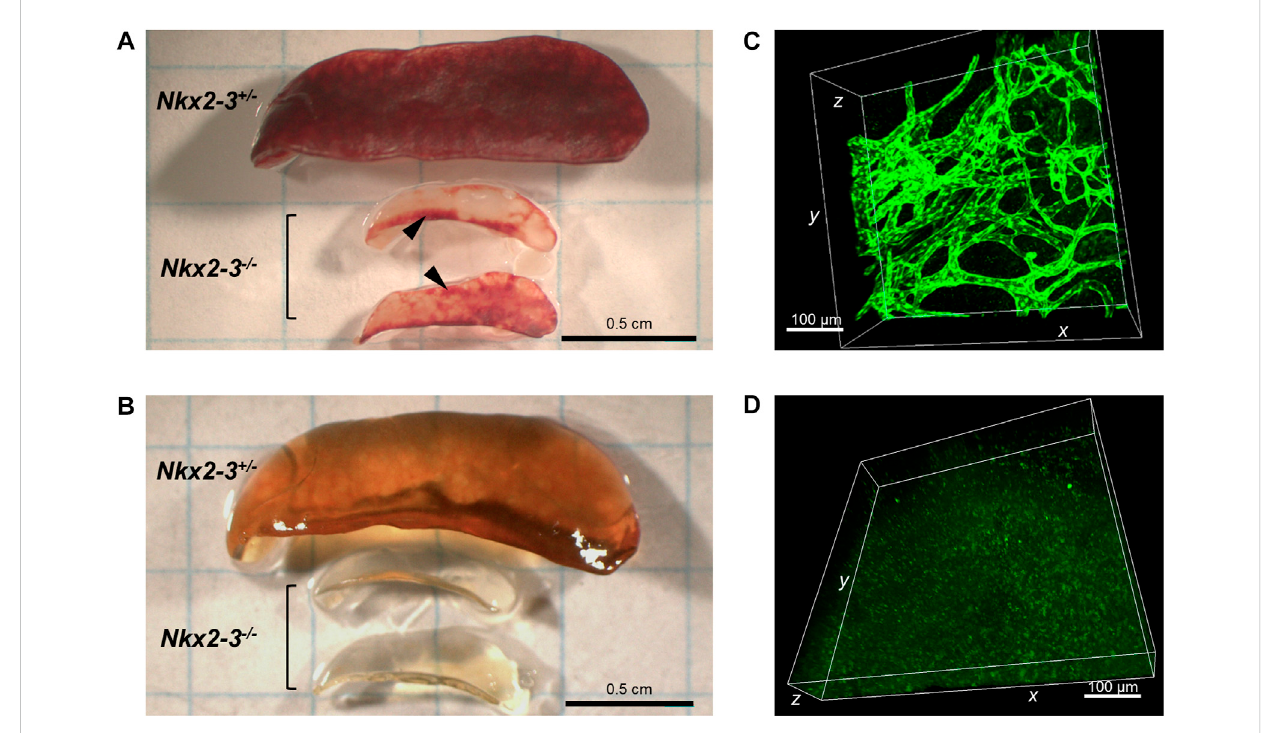
FIGURE 1 Organziation ofProx1-expressing lymphaticcapillariesinNkx2-3 − / − spleens.Compared toheterozygotesample(top)Nkx2-3-de fi cient micehavea reduced spleen size and patchy red pulp appearance (middle and bottom) (A) . Following paraformaldehyde fi xation and transparency treatment of the same samples, the heterozygote tissue (top) could not be clari fi ed due to residual hemoglobin pigment, while the homozygote KO samples (middle and bottom) have become completely transparent (B) . After CUBIC treatment in Prox1 GFP -Nkx2-3 − / − mice (C) an extensive meshwork of LEC capillaries can be observed, while in Prox1 GFP -Nkx2-3 +/- (D) such structures are absent, only faint background auto fl uorescence is detectable. Scale bars in A-B = 0.5 cm; scale bars in C-D = 100 μ m. Representative images of a cohort of n = 3, experiment repeated